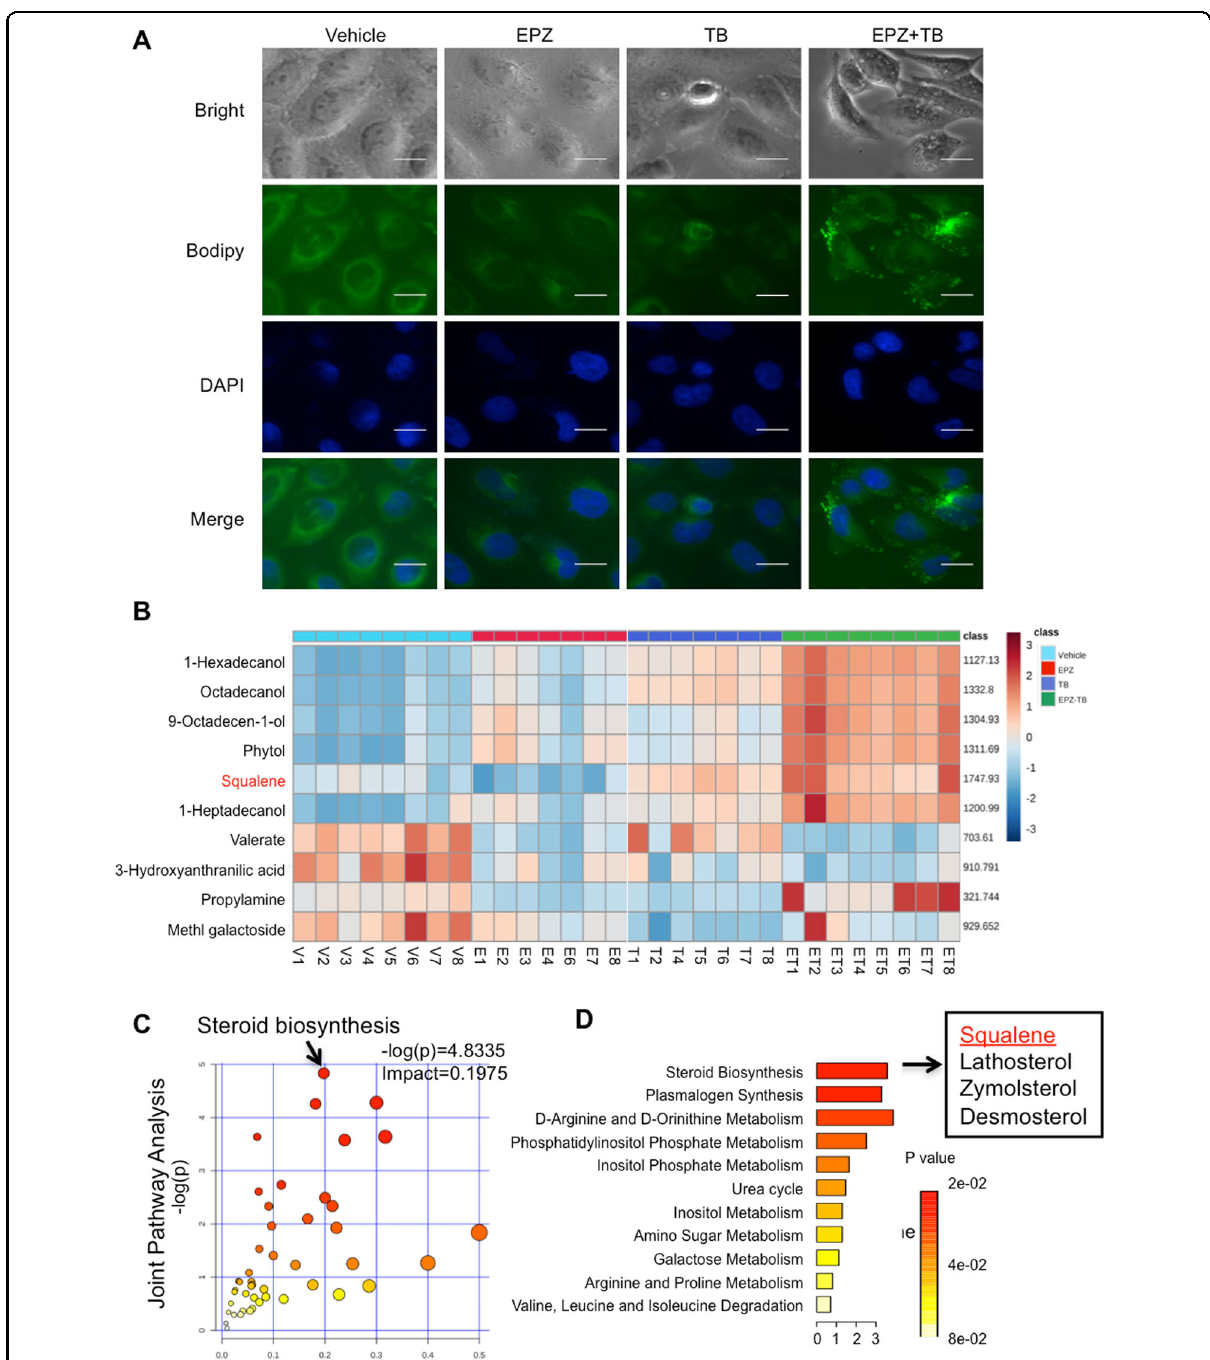
Fig. 4 Double inhibition of EZH2 and SQLE promotes lipid accumulation in HNSCC cells. A Morphological changes and BODIPY staining of neutral lipids in HN6 cells in different treatment groups. Cells were treated with vehicle, EPZ6438, terbina fi ne or the combination for 48 h. Bar = 100 μ m. B Heatmap of the top 10 metabolites with signi fi cant changes among 289 metabolites detected by GC/MS/MS in CAL27 cells after treatment for 72 h. N ≥ 7 replicates. C The combined analysis of gene expression and metabolism pro fi le. The sterol biosynthesis pathway was enriched with the highest score by the combination of EZH2 inhibitor and SQLE inhibitor. D Squalene is one of the four changed metabolites involved in sterol